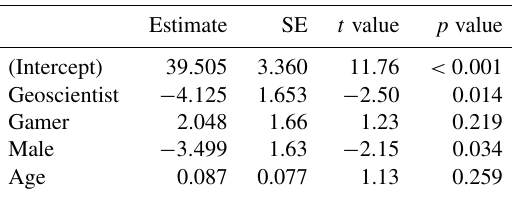
Table A3. Results of the linear regression model predicting penalty scores from dichotomous variables geoscientist, gamer, and male and continuous variable age. Geoscientists and men score significantly better than non-geoscientists and women, respectively. The effect of gamer and age is